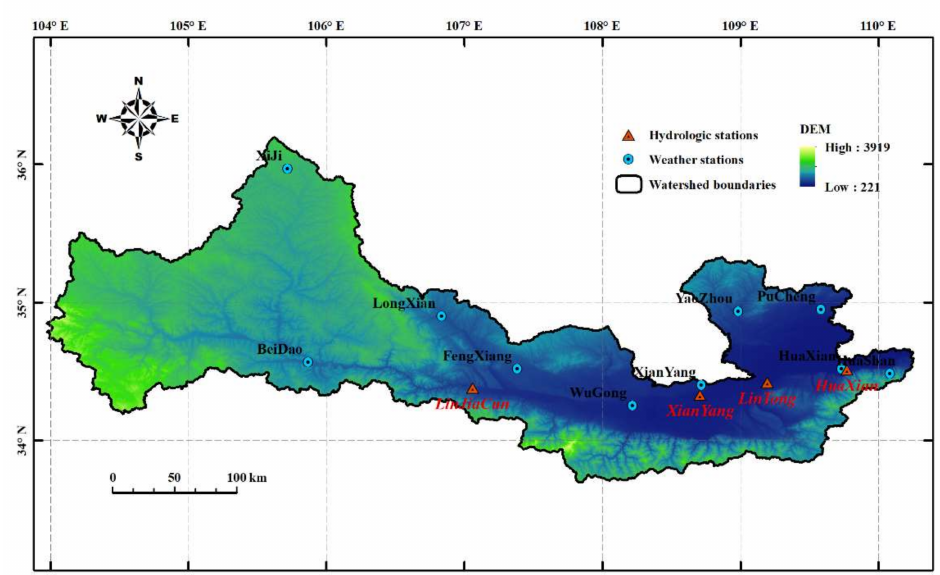
Figure 1. Geographic location of Weihe River basin and its hydrological and meteorological